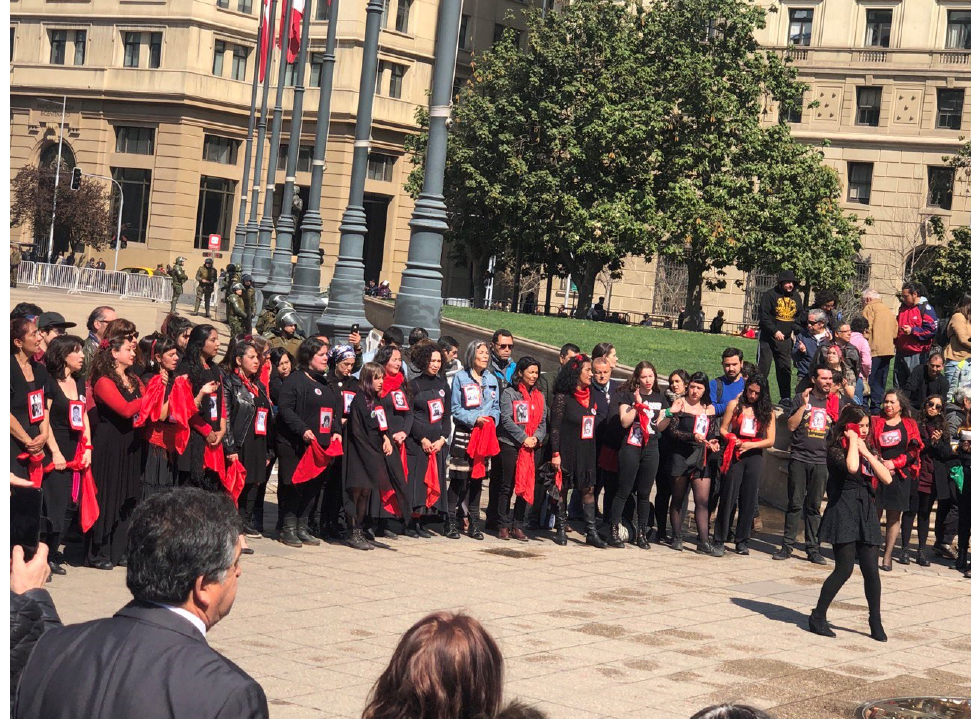
11 September 2019 – La Moneda – Cueca Sola collective performance (Source: Author,